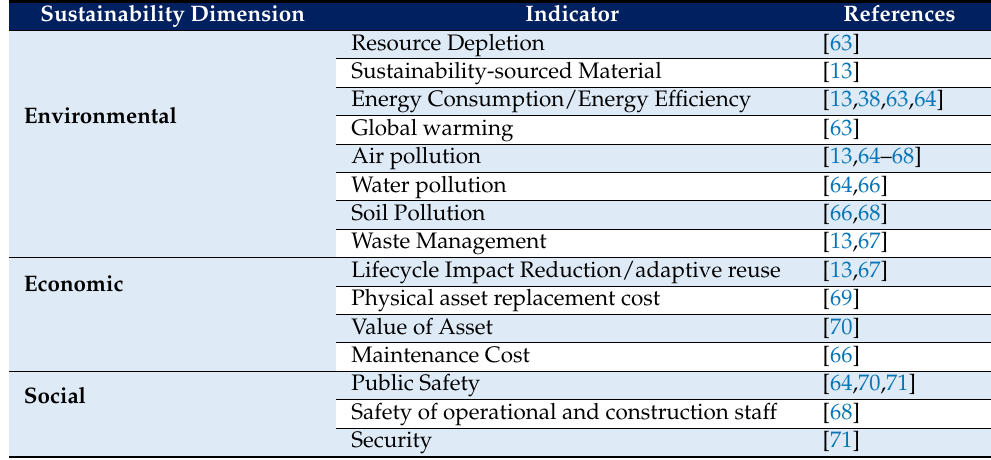
Table 2. Sustainability indicators for physical asset criticality